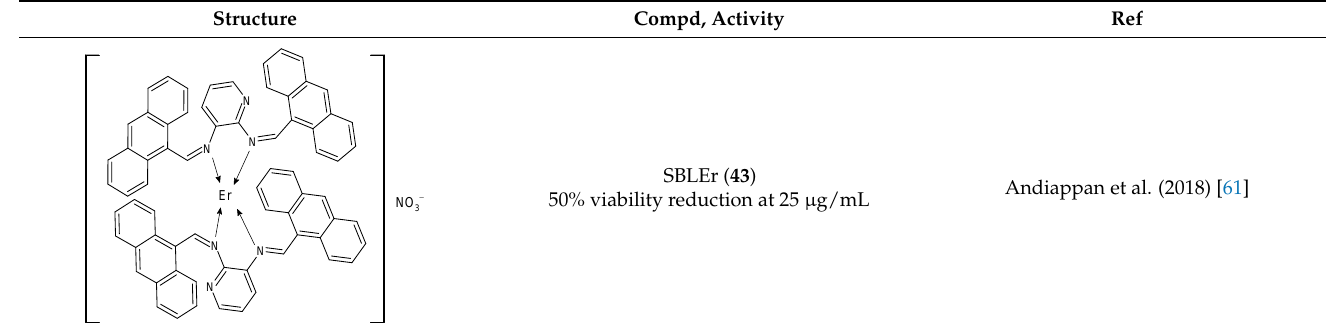
Table 3. Antiproliferative activity of lanthanide-based complexes with Schiff bases. Structure